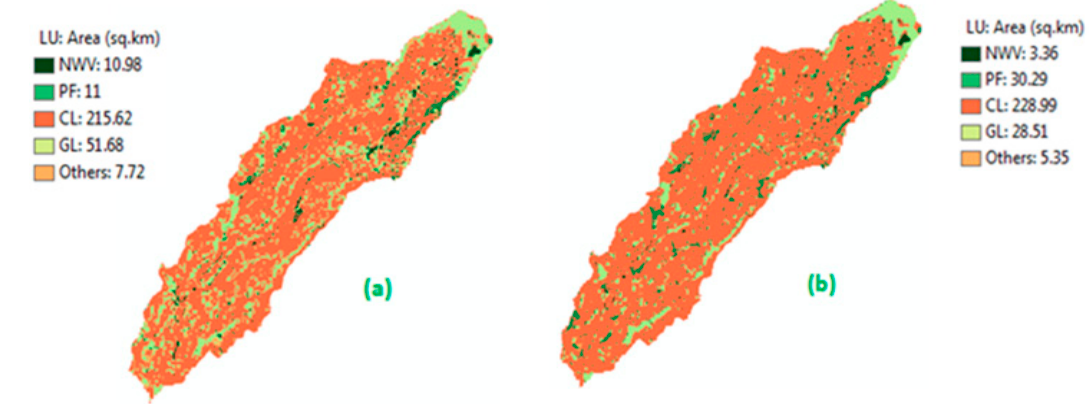
Environments 2016 , 3 , 21 Figure 4. Simulated land-use maps of ( a ) 2009 and ( b ) 2025. Figure 4. Simulated land-use maps of ( a ) 2009 and ( b ) 2025.